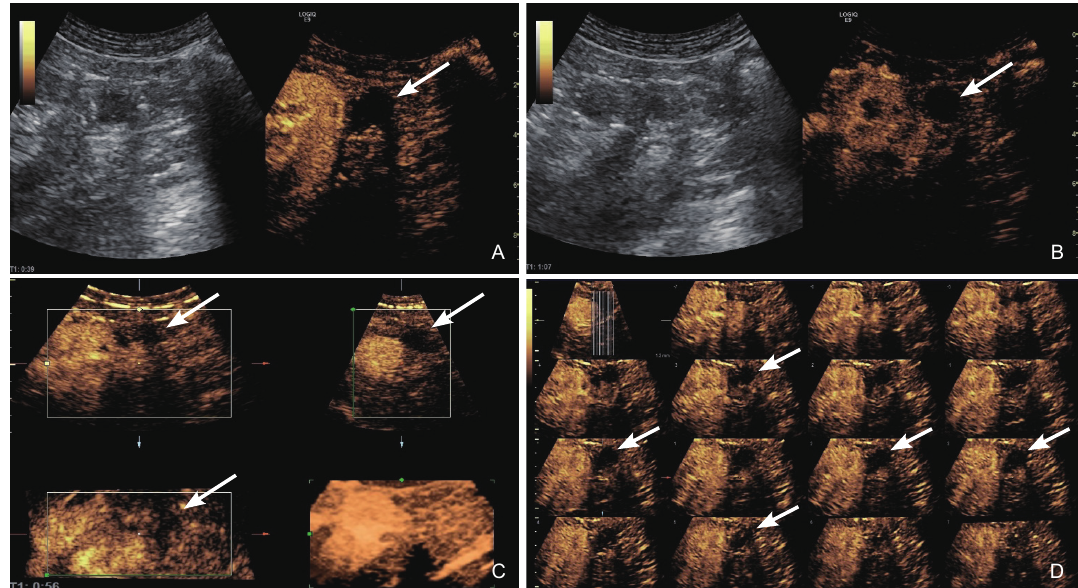
Figure 9 Example of 2D and 3D CEUS of a 2.5 cm ablation cavity (white arrows) 18 months post cryoablation. (A) 2D dual imaging shows no enhancement within the ablation cavity during the arterial phase (39 seconds post injection of 1ml Optison, GE Healthcare); (B) Similar lack of enhancement on 2D CEUS is observed in the later phases (1:07 post injection); (C) Continuous 3D imaging was subsequently performed following a second 1 ml bolus injection. The ablation cavity is well visualized in three orthogonal planes (white arrows) and in the volumetric reconstruction (bottom right panel); (D) Post-processing was then performed to evaluate the volume on a slice by slice basis with slice distances of 1.3 mm in order to confirm lack of enhancement throughout the